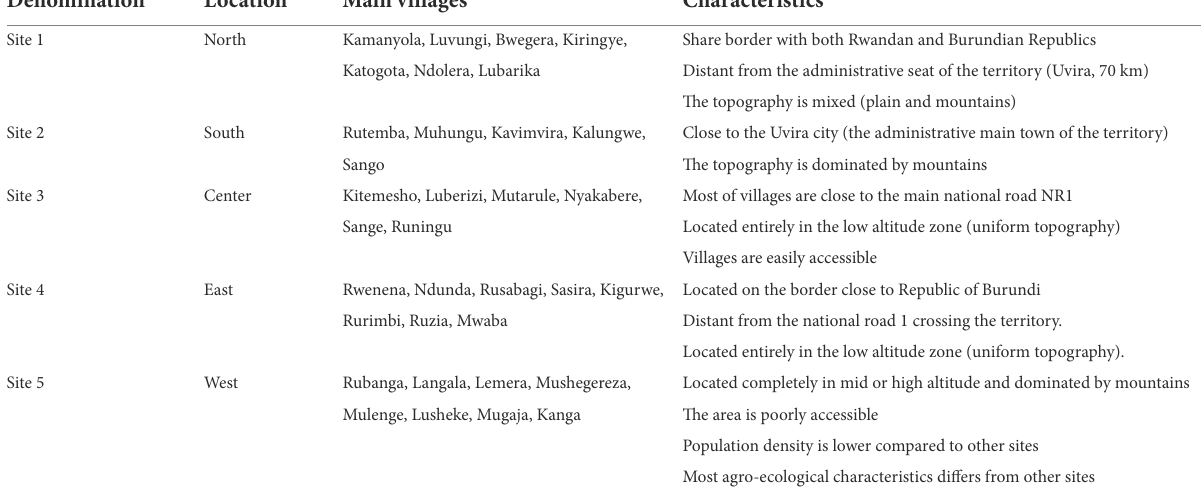
TABLE 1 Characteristics of the five